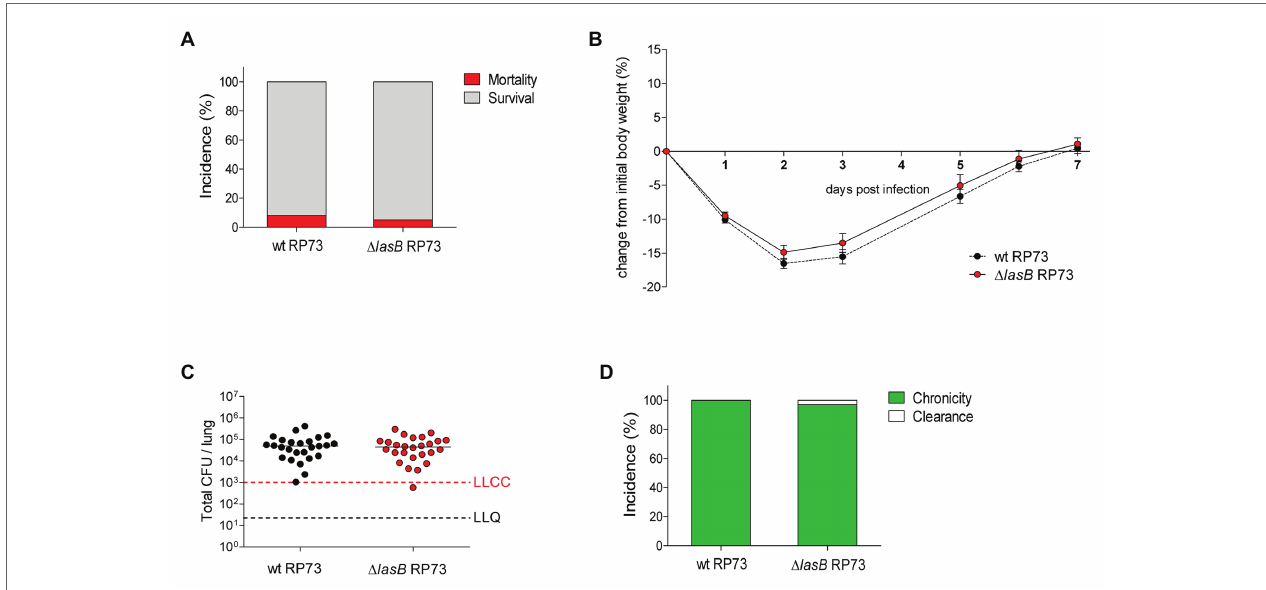
FIGURE 3 | Impact of chronic lung infection by wt and ∆ lasB mutant P. aeruginosa RP73 strains on host response. C57BL/6NCrlBR mice were infected with an average of 3 × 10 5 CFUs/lung embedded in agar beads. Mice were monitored daily for survival and body weight. At Day 7 post-infection, mice were euthanized, and lungs were excised and homogenized. (A) The incidences of survival and mortality were determined on challenged mice and expressed as percentage. (B) Body weight data are expressed as mean ± standard error of the mean (SEM) of the weight change from the initial body weight. (C) CFUs were evaluated in the lungs after plating onto tryptic soy agar at Day 7 post-infection. Dots represent values of individual mice, and horizontal lines represent median values. The lower limit of chronic colonization (LLCC) and the lower limit of quantification (LLQ) are indicated. (D) The incidence of clearance (<1,000 CFUs of P. aeruginosa in the lung cultures) and capacity to establish chronic airways infection (≥1,000 CFUs of P. aeruginosa in the lung cultures) were determined on surviving mice at Day 7 post- infection and expressed as percentage. The data were pooled from three independent experiments (mice nr =